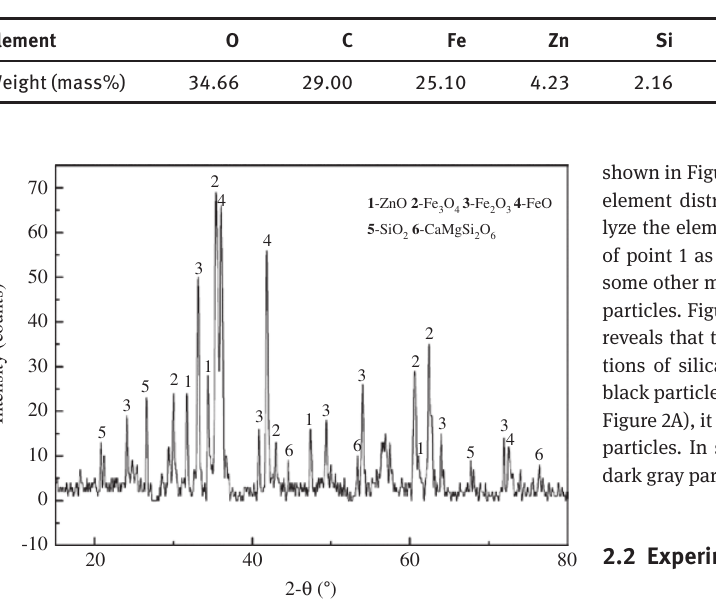
Table 1: The chemical composition of blast furnace dust.